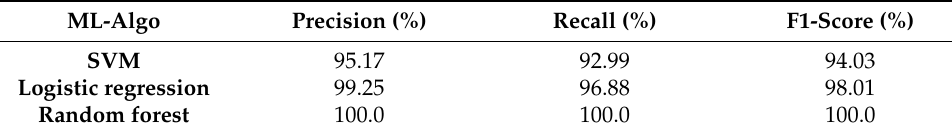
Table 1. Estimation